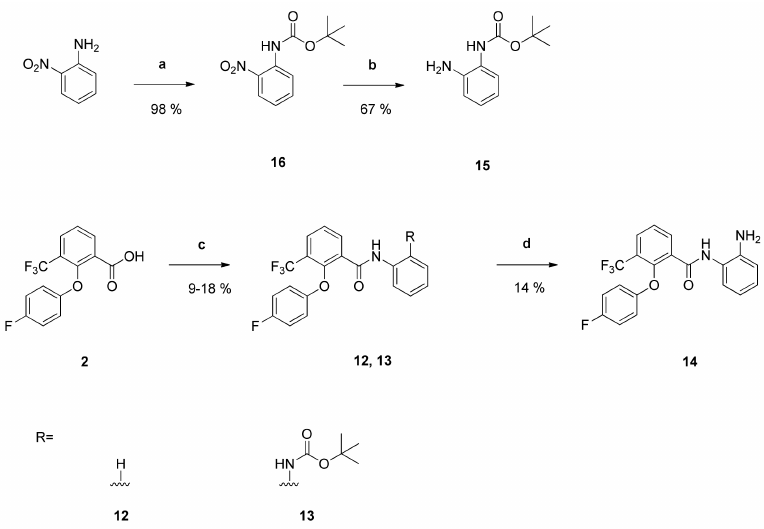
Figure 3. Preparation of compounds 12 , 13 and 14 . Reagents and conditions: ( a ) triethylamine, di- tert -butyldicarbonate, CH 2 Cl 2 , rt, 24 h; ( b ) 15% (m/m) palladium on activated carbon, H 2 , Me OH, rt, 24 h; ( c ) (1) aniline or compound 15 , CH 2 Cl 2 , 0 ◦ C, 5 min; (2) 2-chloro- N -methylpyridinium iodide, DIPEA, rt, 24 h; ( d ) trifluoroacetic acid, CH 2 Cl 2 , rt, 24